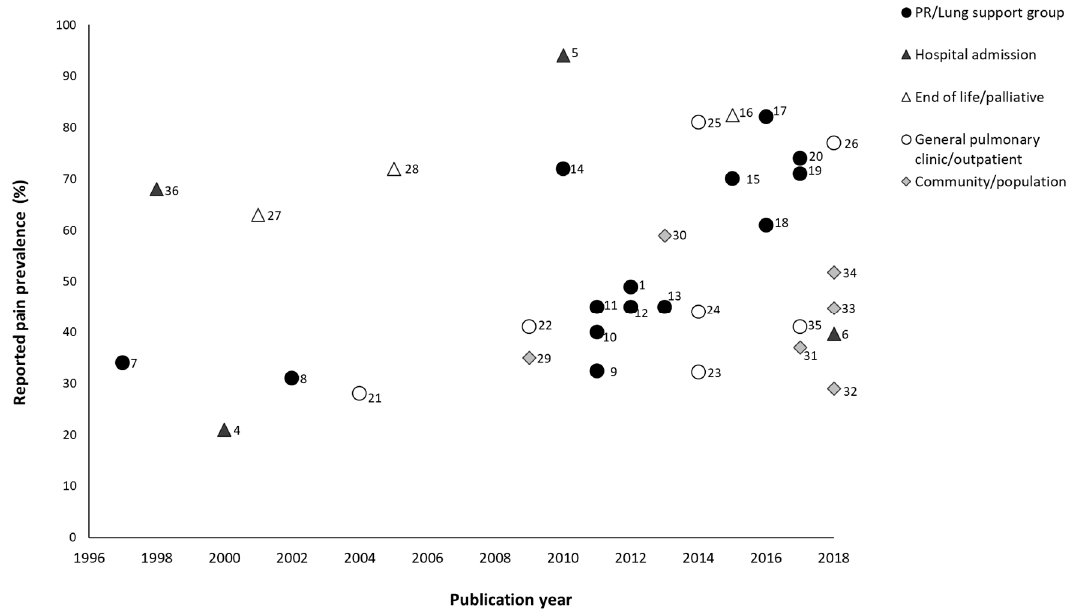
Figure 1. Pain prevalence reported within studies by the clinical population. PR, pulmonary